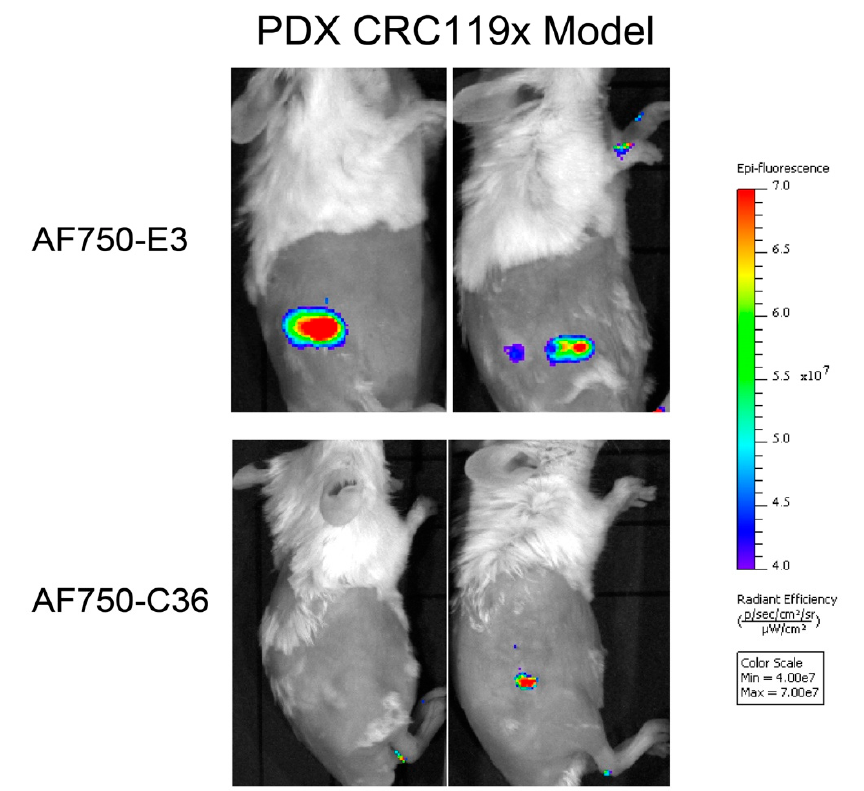
Figure 6. The E3 aptamer targets PDX tumors in vivo. PDX CRC119x colorectal tumors were established in the right flank of NOD/ScID mice. Tumor-bearing mice were injected via tail vein with 2 nmol of AF750-E3 ( n = 3) or of control AF750-C36 ( n = 2) and imaged for NIR fluorescence. Shown are representative images from 48 h post-aptamer injection.